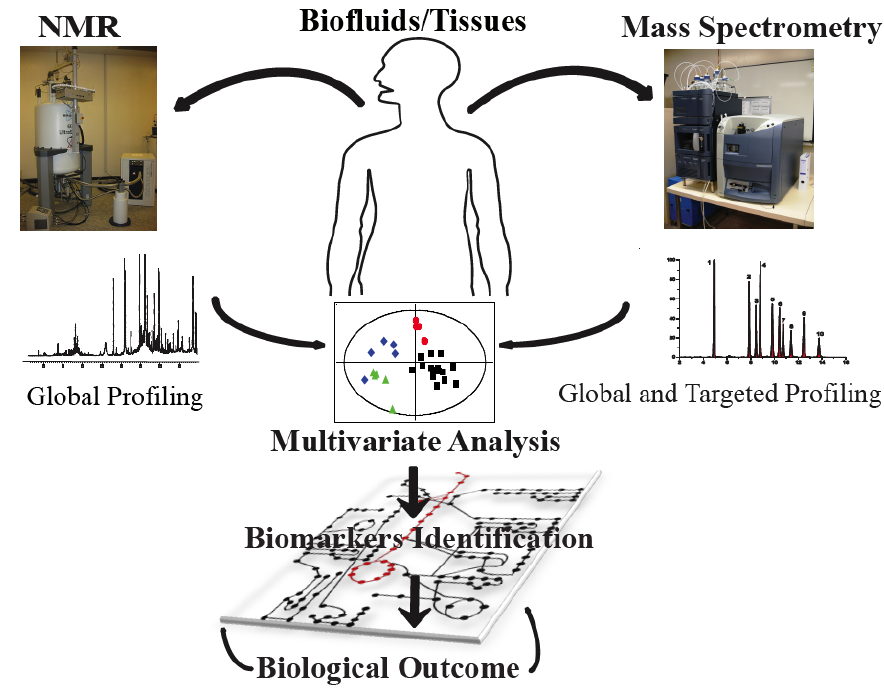
Figure 1. Scheme describing a typical NMR (Bruker 600 MHz) and MS (Waters Acquity Ultra Performance Liquid Chromatograph) based metabonomic analytical platform.